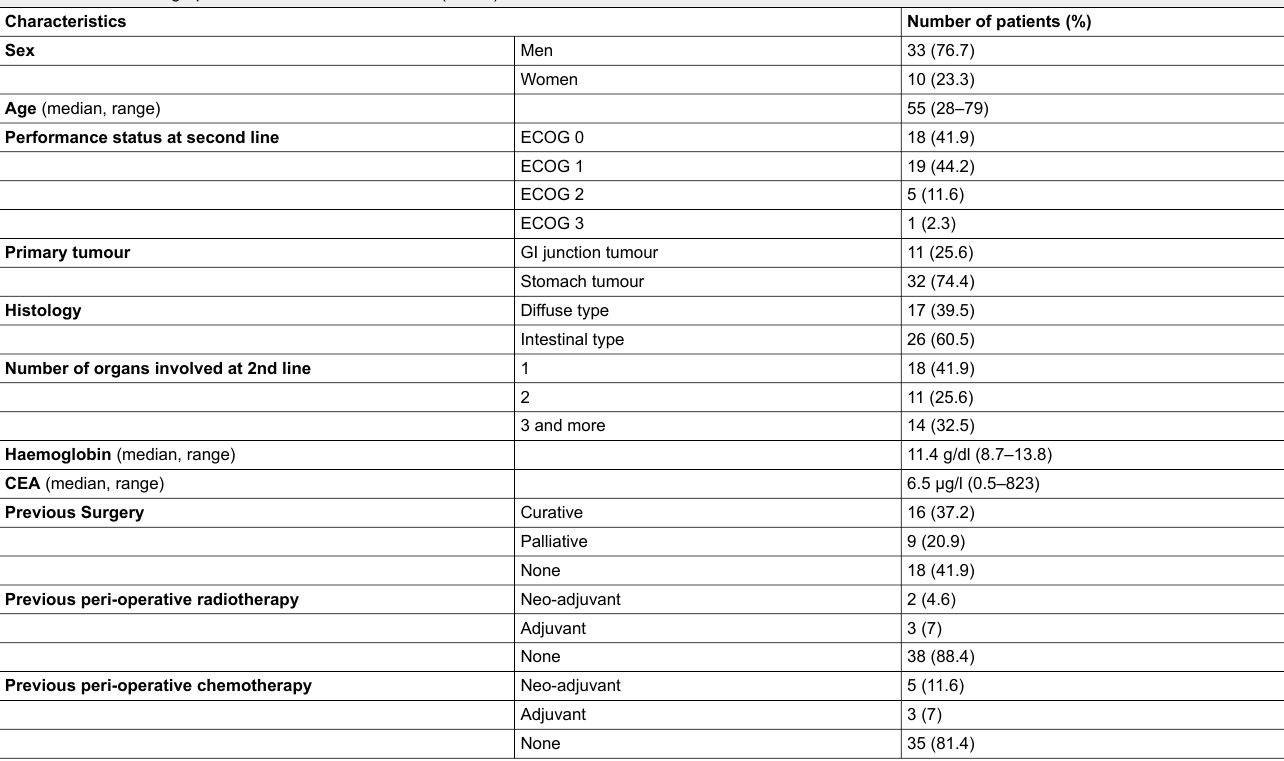
Table 2: Patient demographics and clinical characteristics (n =